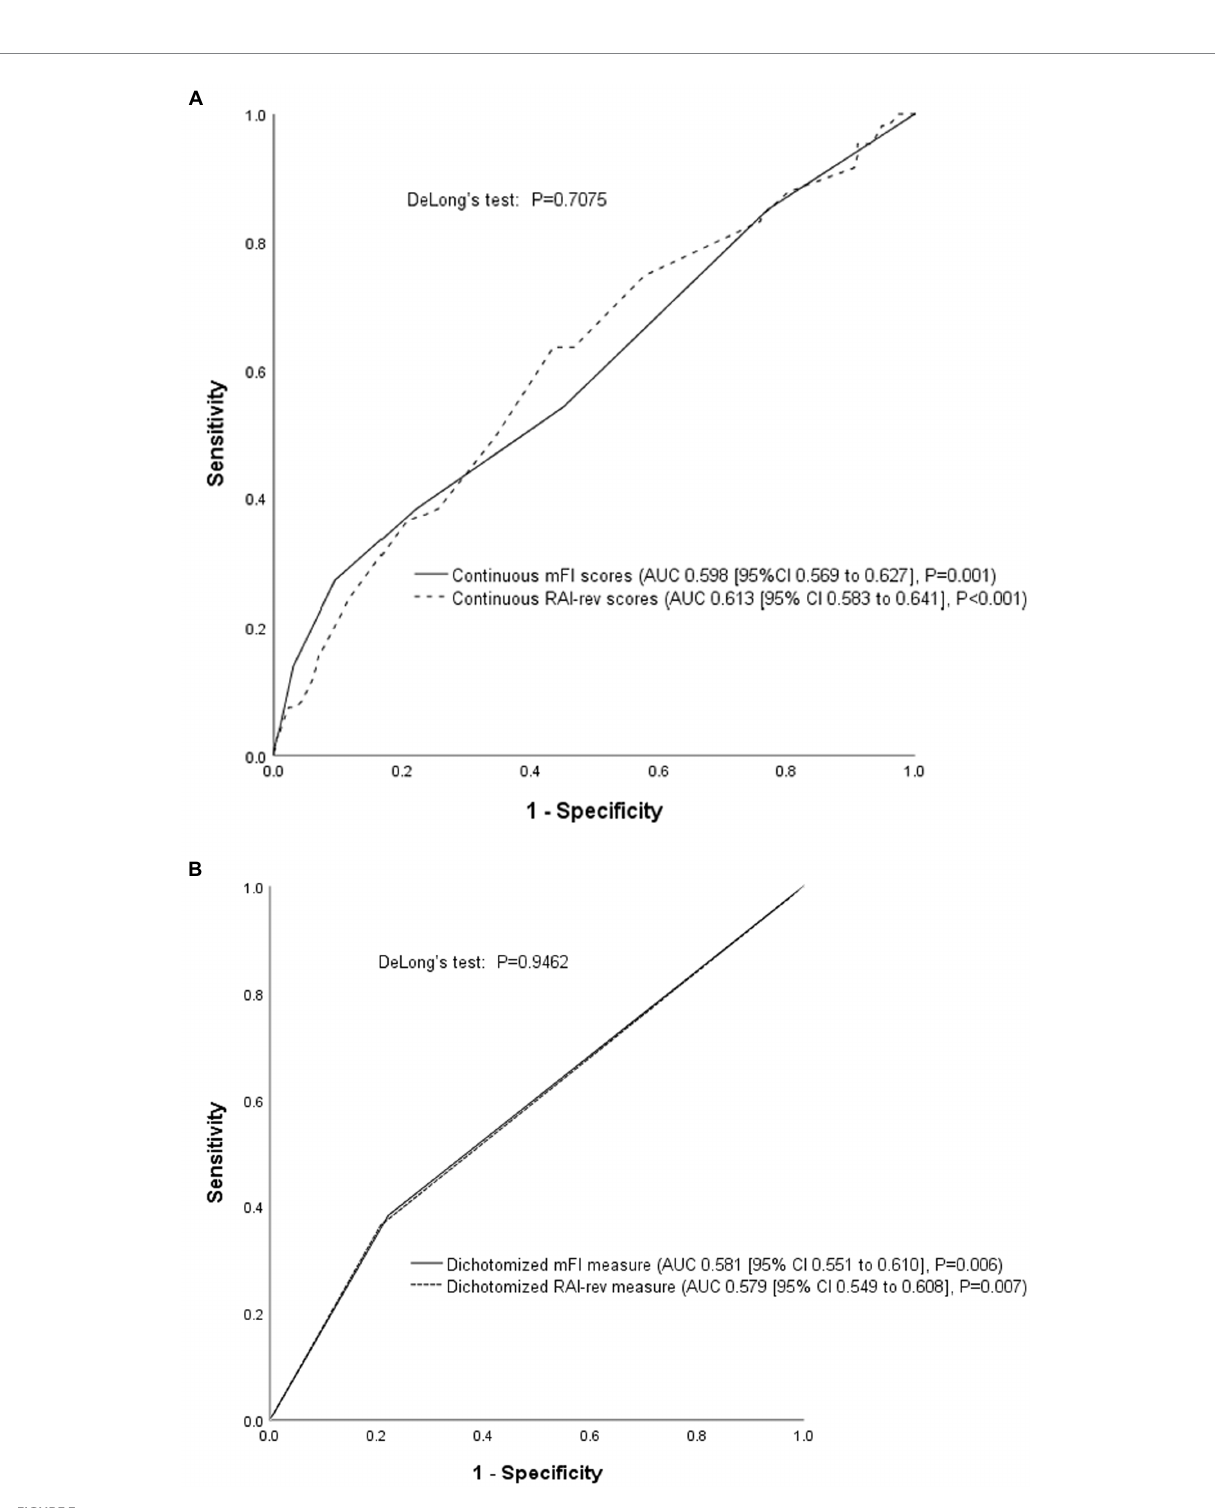
FIGURE 3 Receiver operating characteristic (ROC) curve analysis. (A) Comparison of the continuous mFI and RAI-rev scores; (B) Comparison of dichotomized mFI and RAI-rev measures. ROC curve analyses showed that the performances of mFI and RAI-rev were poor and comparable in predicting life- threatening morbidity and mortality. MFI, modified frailty index; RAI-rev, revised-Risk Analysis